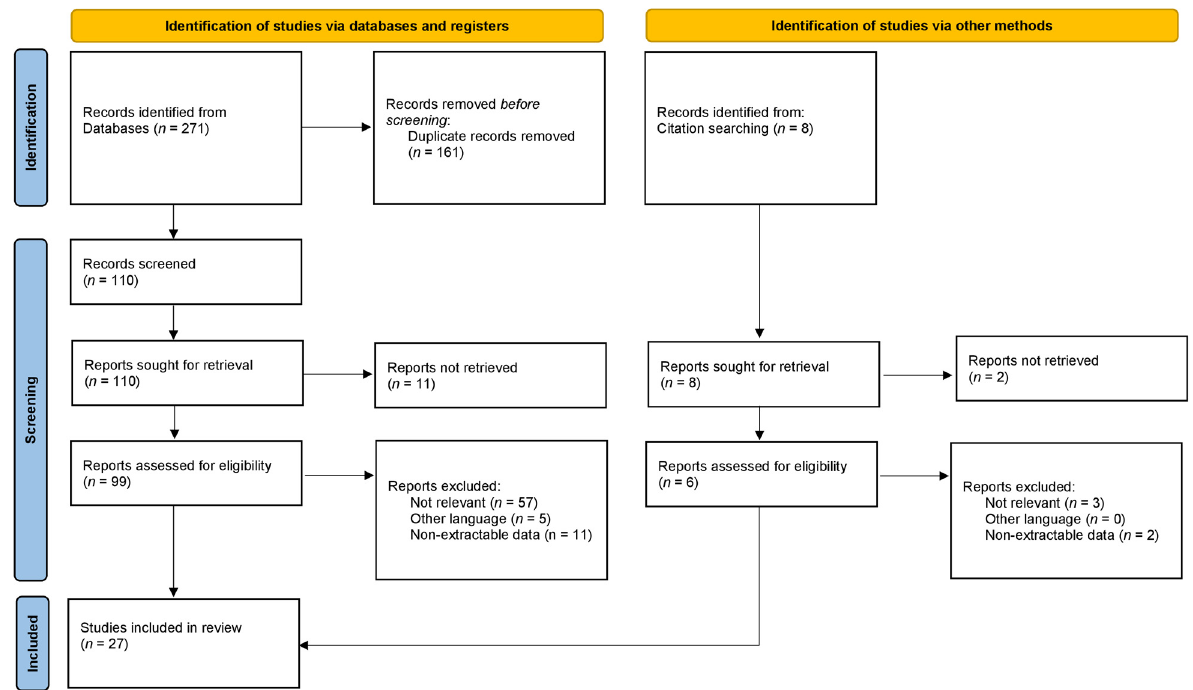
Figure 1. PRISMA 2020 flow diagram and the selection of studies.